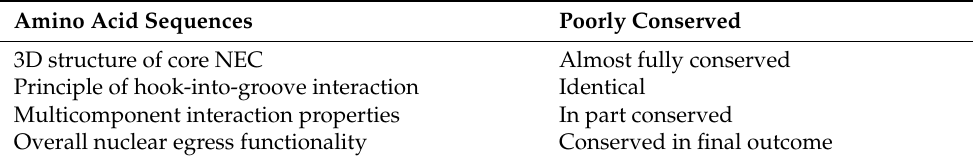
Table 1. NEC conservation between